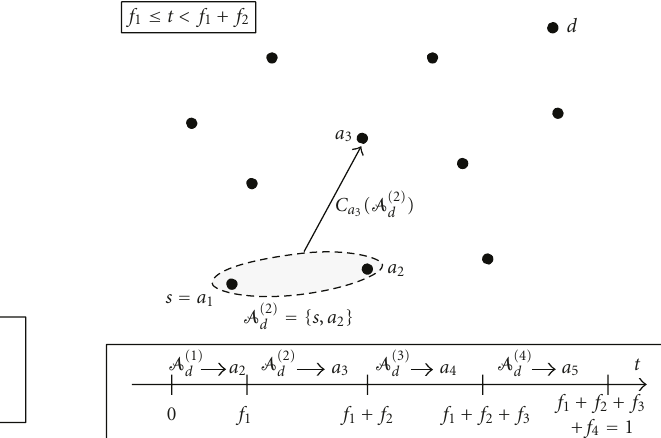
Figure 1: Illustration of an MH route ( M = 3 hops). Figure 2: Illustration of the OST scheme ( M =